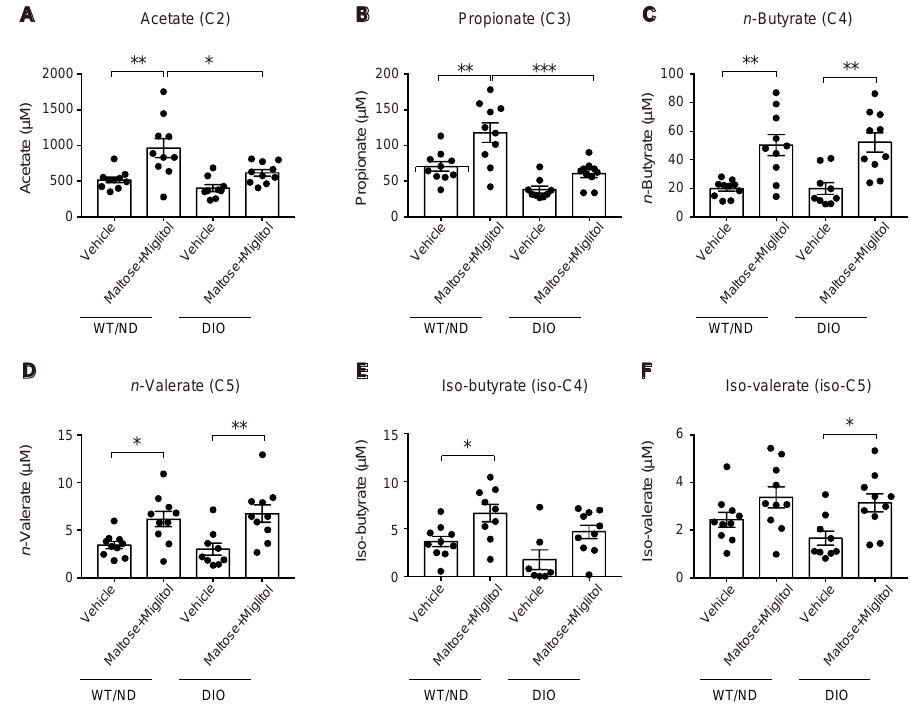
Figure 4. Plasma short-chain fatty acid (SCFA) levels in the portal vein after maltose/miglitol administration. A – F : Plasma SCFAs (acetate ( A ), propionate ( B ), n- butyrate ( C ), n- valerate ( D ), iso-butyrate ( E ), and iso-valerate ( F )) in the portal vein at 30 min after oral administration of maltose + miglitol or vehicle to DIO and WT/ND mice. The data of the control mice are the same as those published previously by Lee et al. [12] and are presented for comparison with those of DIO mice. Bars depict mean ± SEM. * p < 0.05, ** p < 0.01, *** p < 0.001.